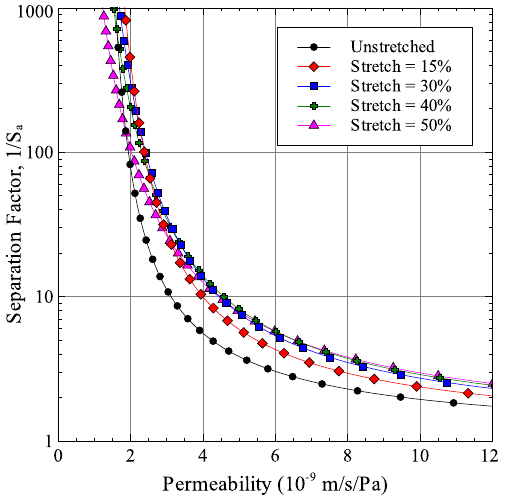
Figure 9. Effect of membrane stretching on permeability-selectivity trade-off.